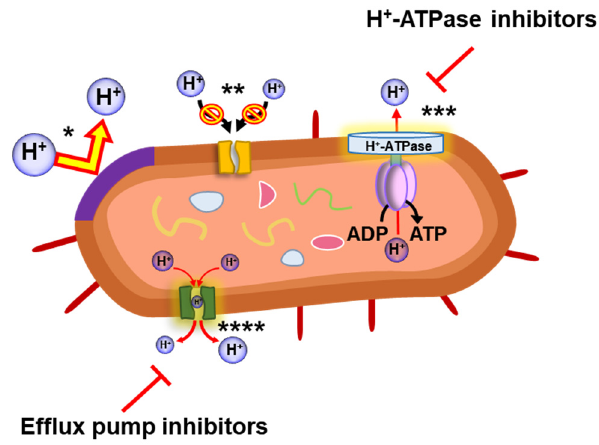
Figure 5. Bacterial acid stress responses, including the decrease in cell membrane fluidity (*), the modification of membrane channel size (**), the proton efflux by H + -ATPase mechanism (***), and the proton pump (****).